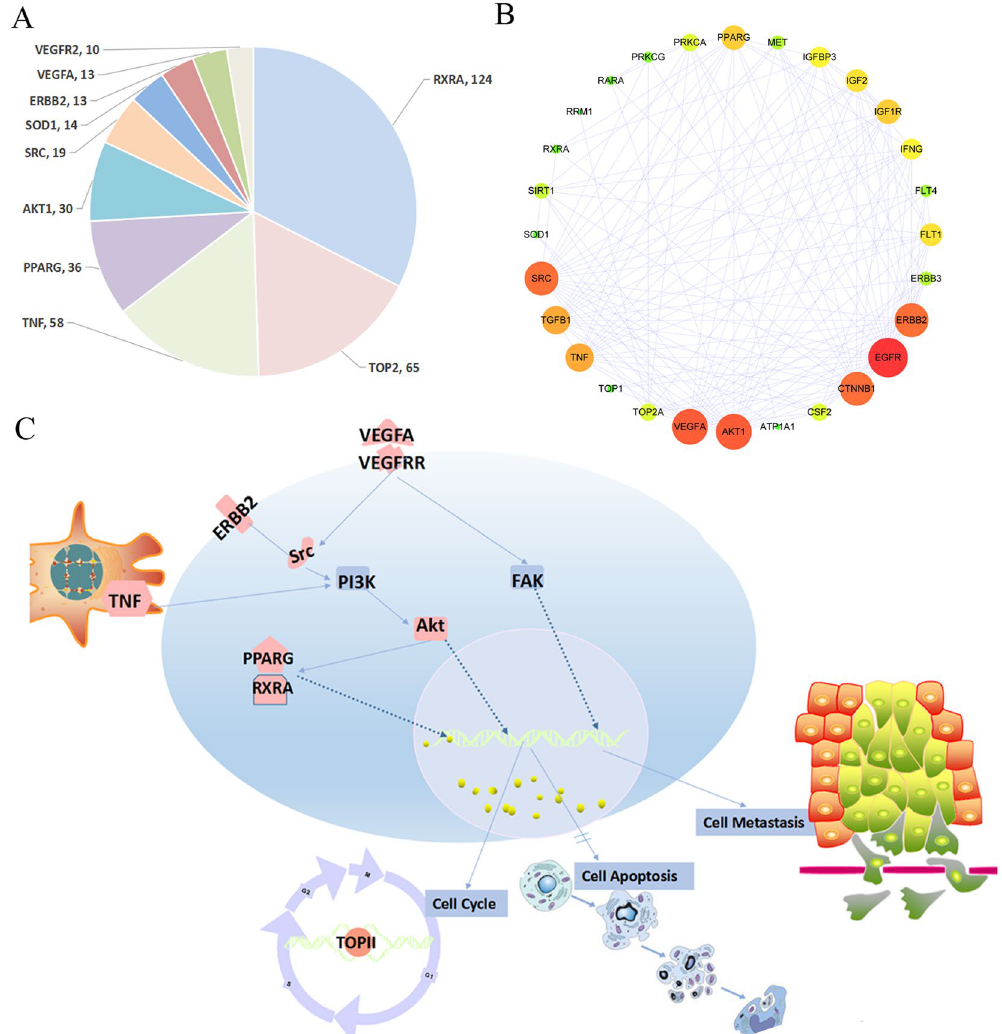
Figure 7. Signaling pathways involved in the actions of the 18 herbs against colorectal cancer. ( A ) Major predicted targets (could be targeted by more than 10 ingredients) were listed according to the scores from high to low. ( B ) Protein-protein interaction of all the candidate protein targets. The map node size gets larger with increased degree and the map color gets bright from green to red with increased degree. This figure was drew using cytoscape with the protein-protein interactions getting from STRING 48,49 . ( C ) The 18 herbs might exhibit anti-colorectal cancer activity mainly via 1) inhibition of the proliferative activity of ErbB2, PPAR γ , and RXR, 2) suppression of angiogenesis by inhibiting VEGFR and VEGFA expression, 3) inhibition of the PI3K/Akt signaling pathway directly through Src and Akt, and 4) reduction of TNF-induced